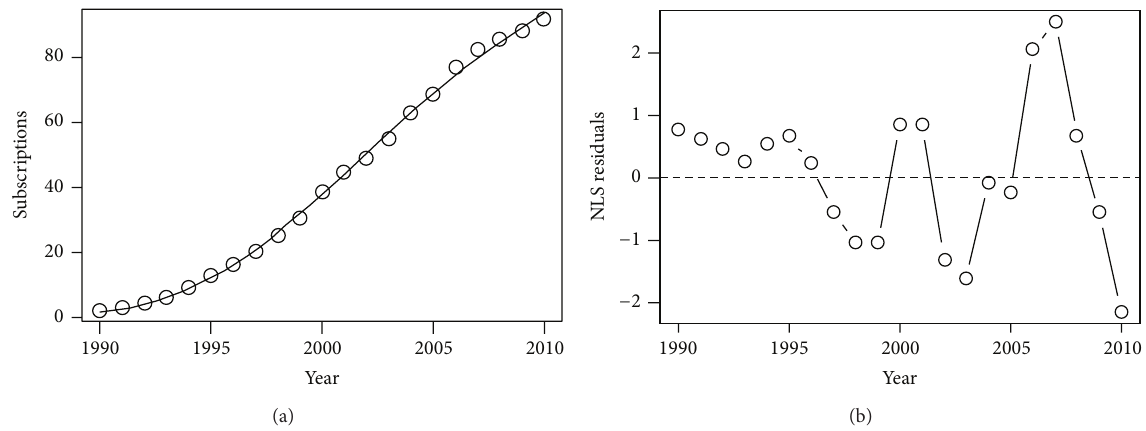
Figure 2: Mobile phone subscriptions (per 100 people) and NLS fit (a), NLS residuals plots (b).